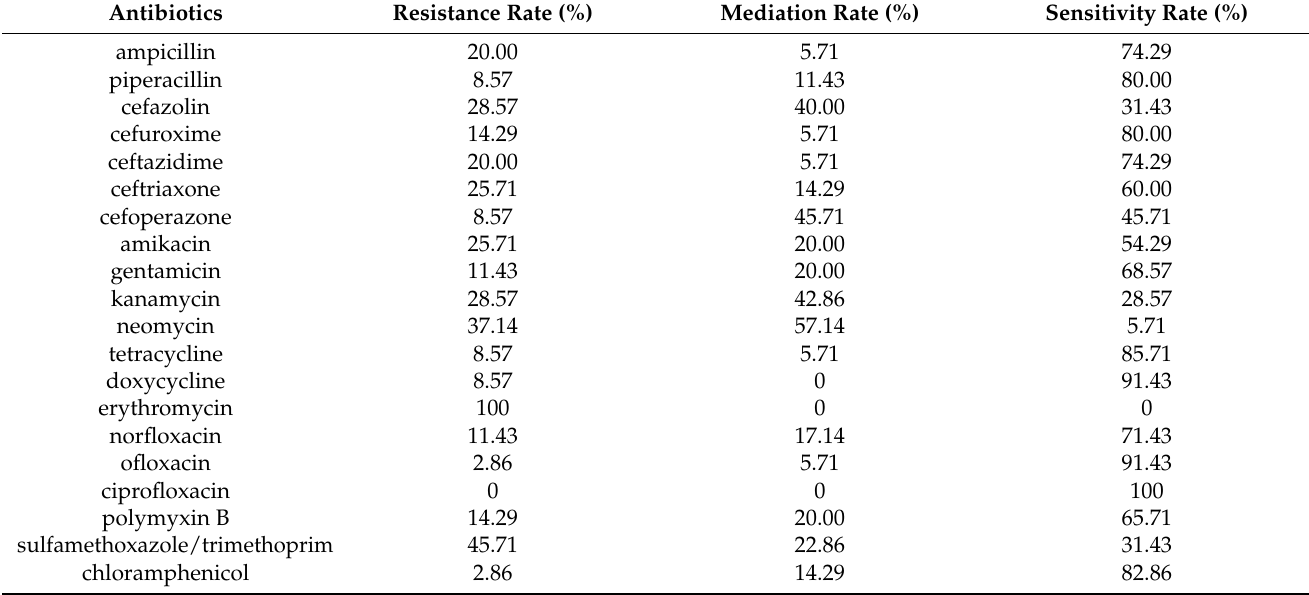
Table 3. Single antibiotic resistance of 35 Cronobacter